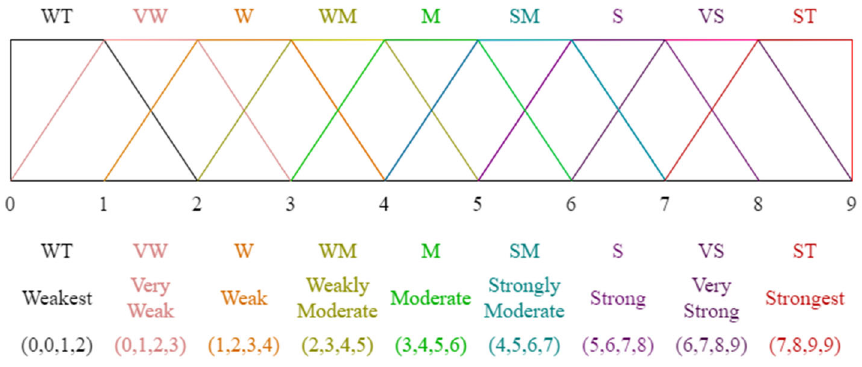
Figure 10. Linguistic scale.